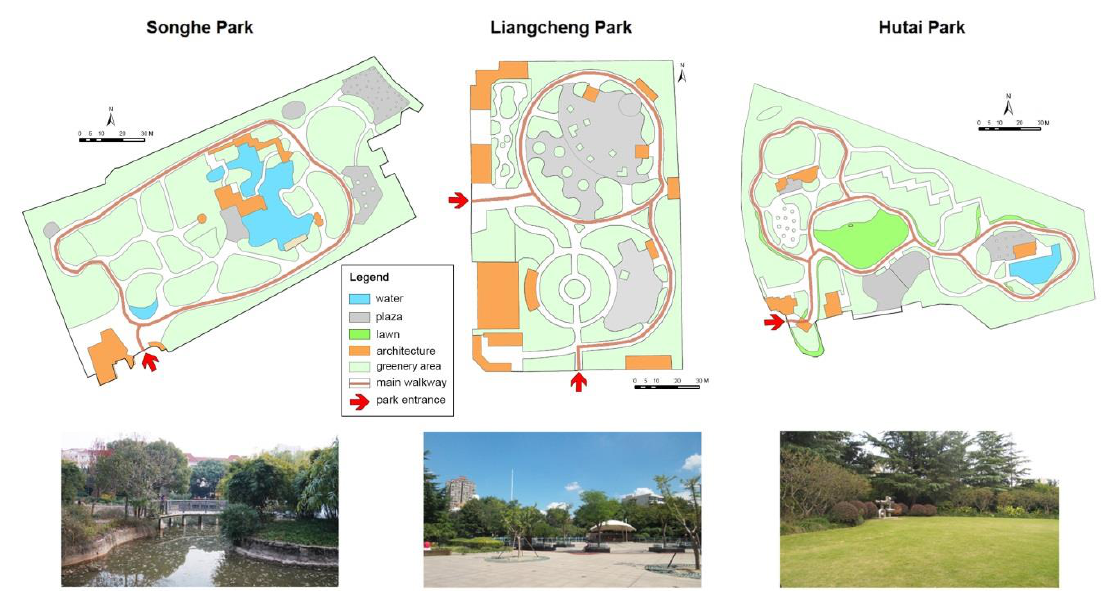
Figure 2. The plan and photo of the three neighborhood parks, with distinct features of water, plaza, and lawn respectively.